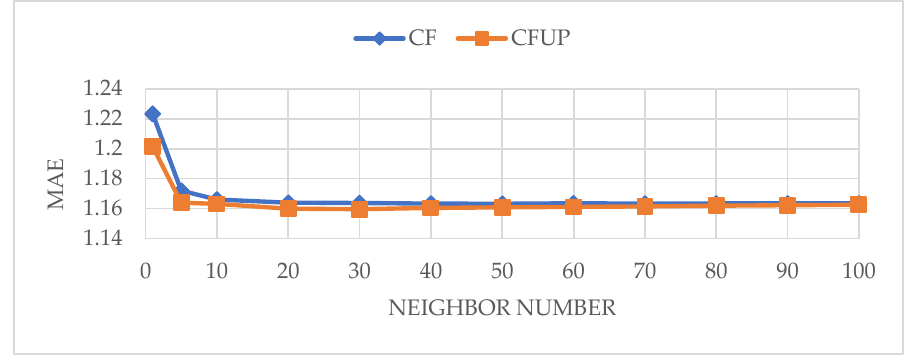
Figure 12. The comparison results of CF and CFUP.